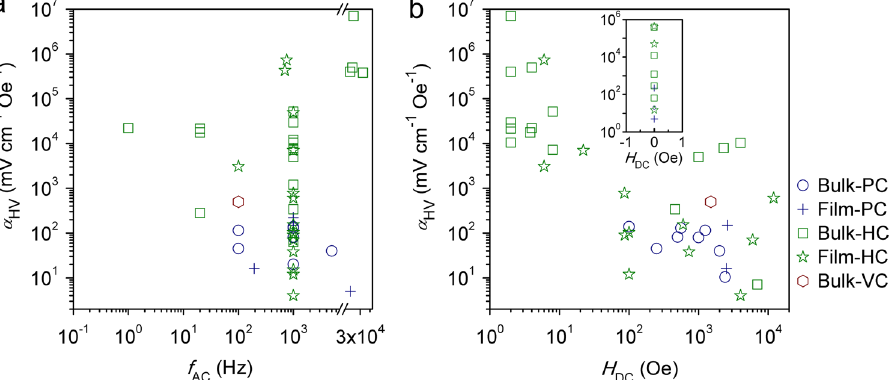
Fig. 10 Some experimental reports of direct magnetoelectric coupling in bulk and thin- fi lm magnetoelectric composites, sorted by plotting the magnetoelctric voltage coef fi cient α HV ( = Δ E / Δ H ) as a function of a the frequency of the driving AC magnetic fi eld ( f AC ), and b the DC bias magnetic fi eld ( H DC ). PC Particulate Composites, HC Horizontal Composites, VC Vertical Composites